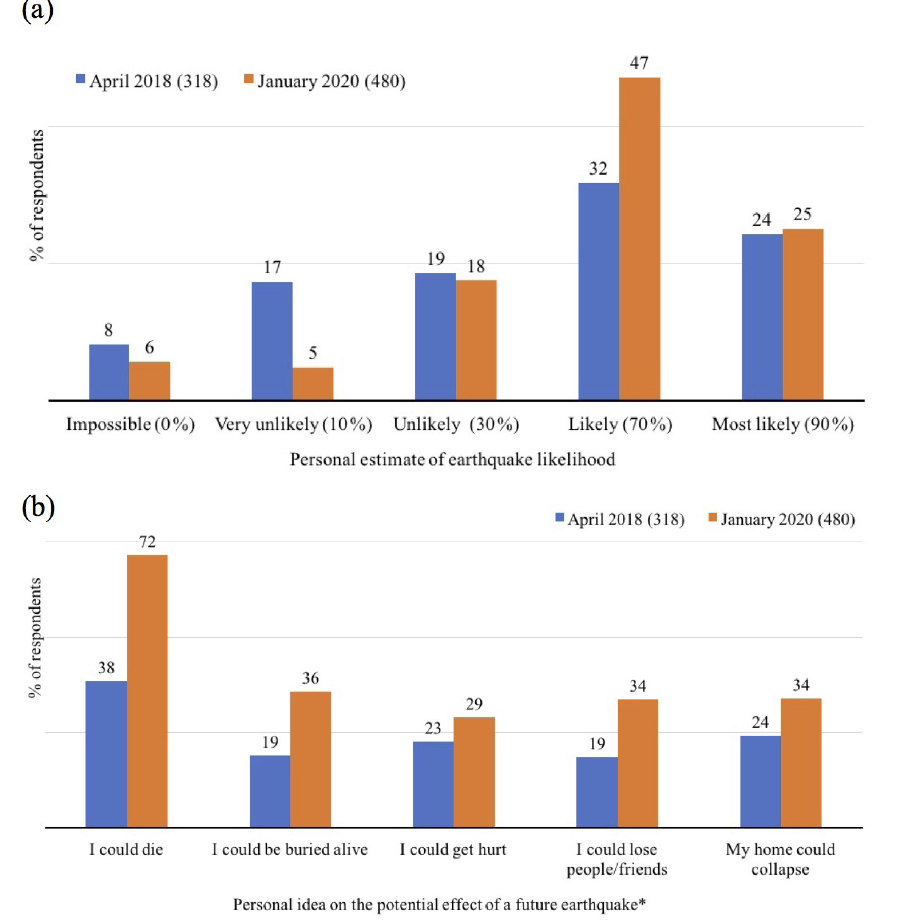
Figure 6. (a) Student views on how likely the occurrence of another earthquake bigger than the 2015 Gorkha earthquake is (Q3), before and after the initiation of our education program ( χ 2 = 43 . 59, p value = < 0 . 00001; the change is significant.). (b) Student answers on the outcome of a potential M w > 8 earthquake in Nepal (Q2), before and after the initiation of our education program. Note: ∗ – Multiple answers were